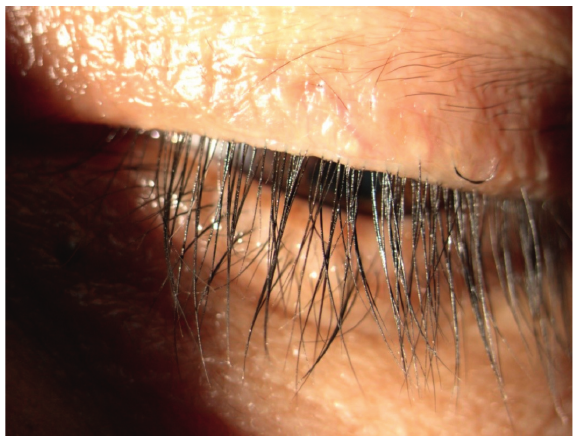
Figure 3: Following treatment with lotilaner ophthalmic solution, 0.25% for 28 days, the lid margin in the left eye of patient 009 is greatly improved, with no evidence of